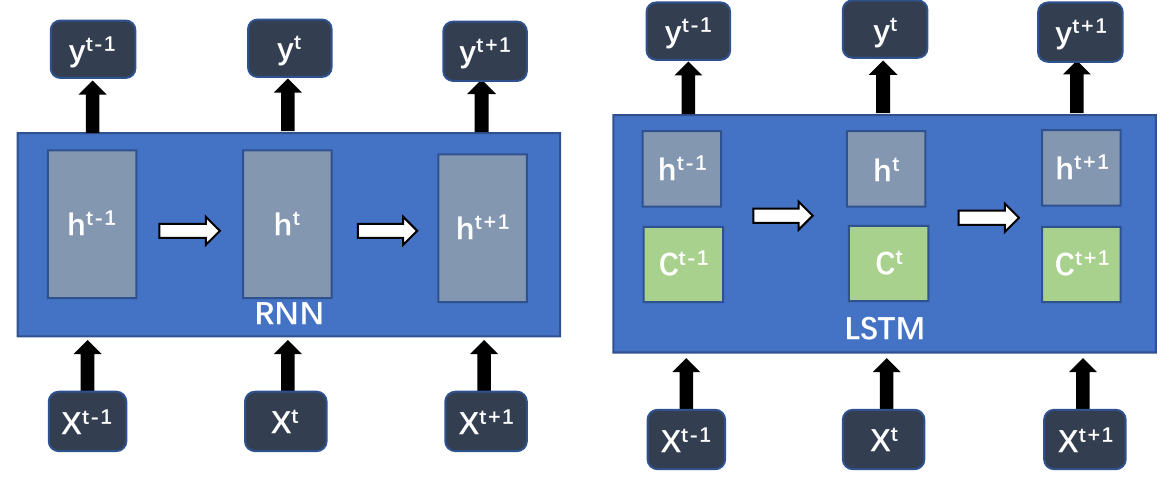
Figure 4. LSTM structure compared with an ordinary RNN.